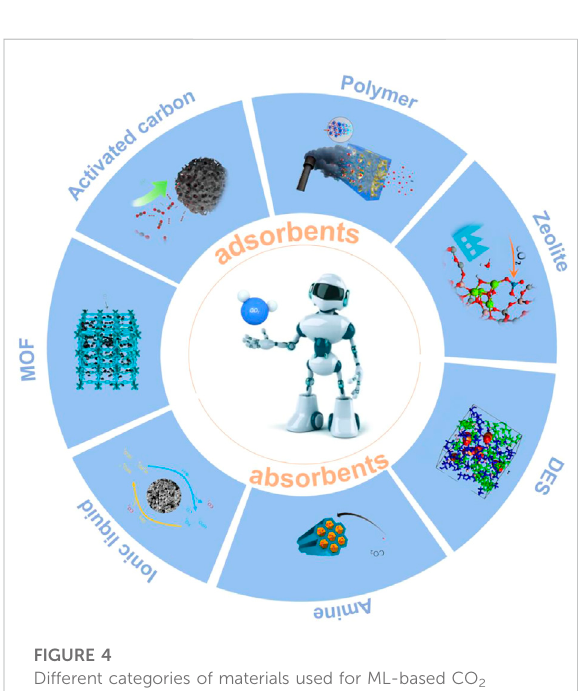
FIGURE 4 Different categories of materials used for ML-based CO 2 capture